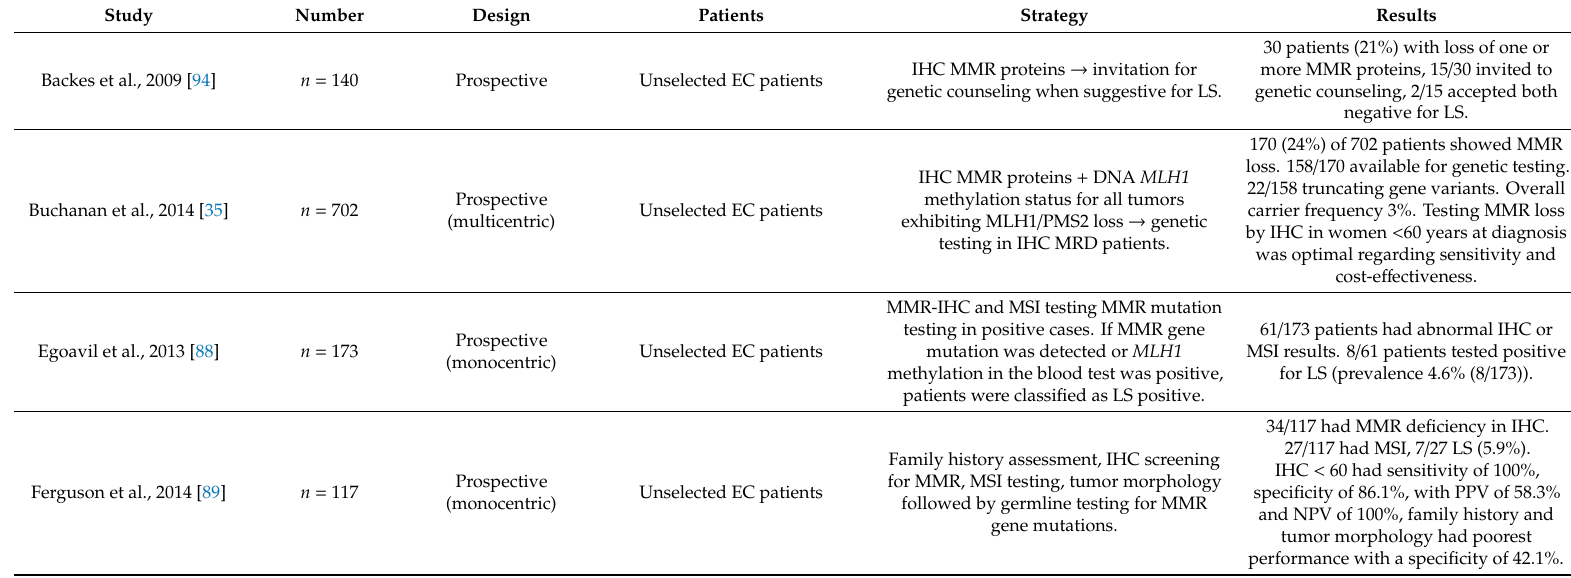
Table 2. Cohort studies investigating screening strategies for hereditary syndromes among endometrial cancer (EC)